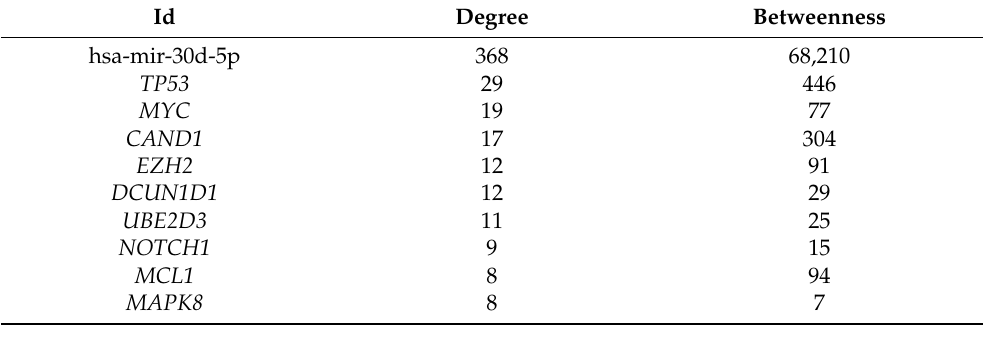
Table 1. Degree and betweenness centrality values of miR-30d-5p and its targets in the miRNA-gene and protein–protein interaction network that were generated by the miRNet tool. The degree of a node presents the number of connections it has to neighboring nodes. Betweenness centrality values present the number of shortest paths that go through the node of interest in the network. The top 10 hits are presented. Id